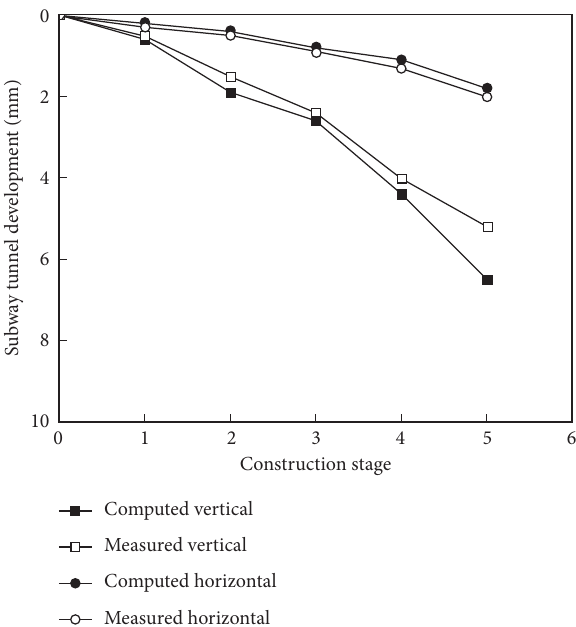
Figure 16: Maximum deformation of the subway tunnel.